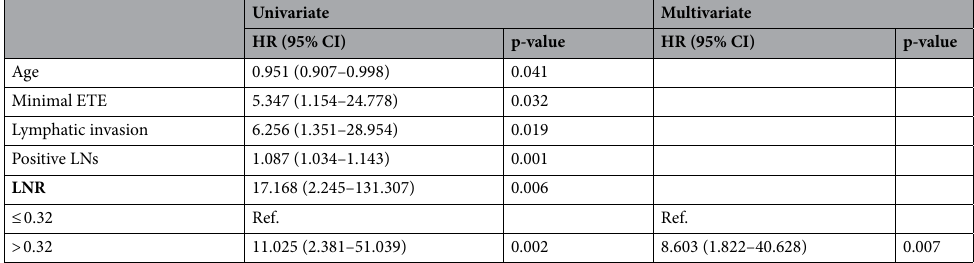
Table 7. Univariate and multivariate analyses of disease-free survival. Data were expressed as hazard ratio (HR) and 95% confidence interval (CI). A statistically significant difference was defined as p < 0.05. ETE extrathyroidal extension, LN lymph node, LNR lymph node ratio.